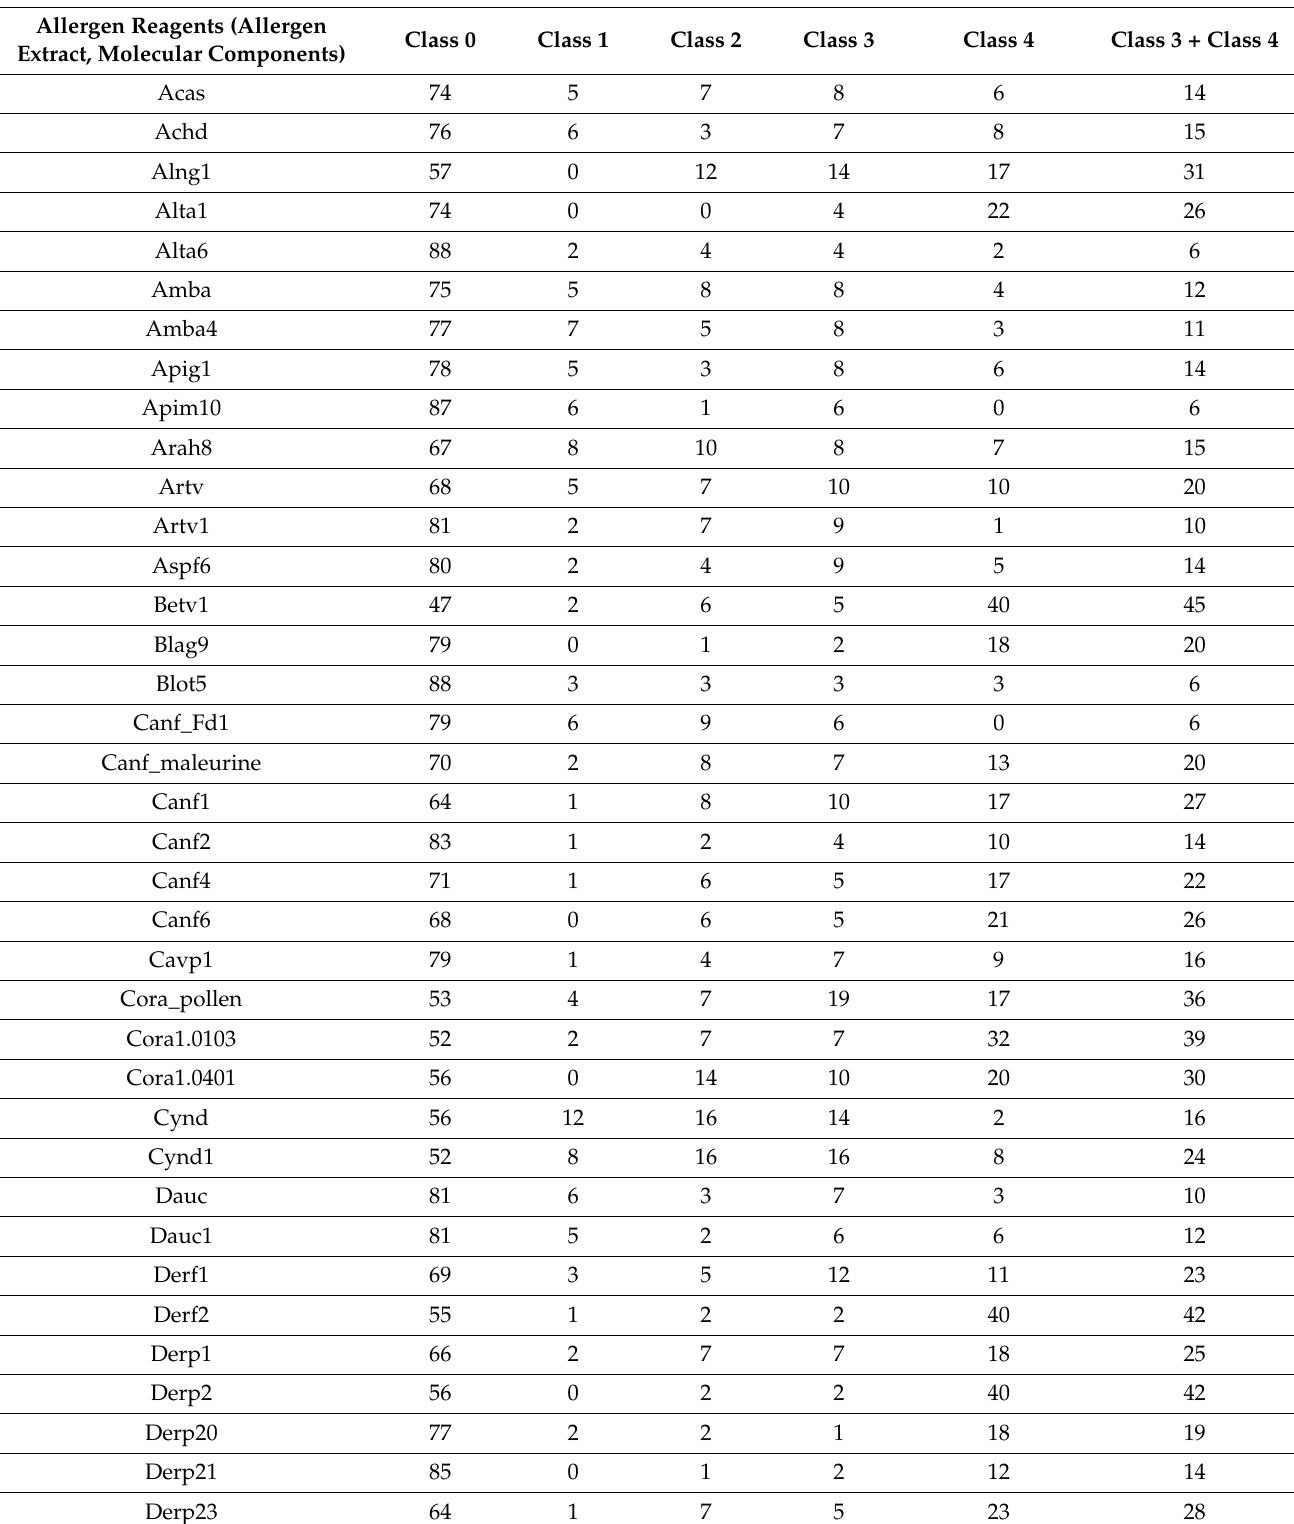
Table 3. Allergen reagents (molecular components) with the level of specific IgE in Classes 3 and 4 with the positivity in 6 and more patients. We also show the sensitization rate of 75 selected molecular components in the classess 0, 1, 2 (analysis according to TURF—total unduplicated reach and